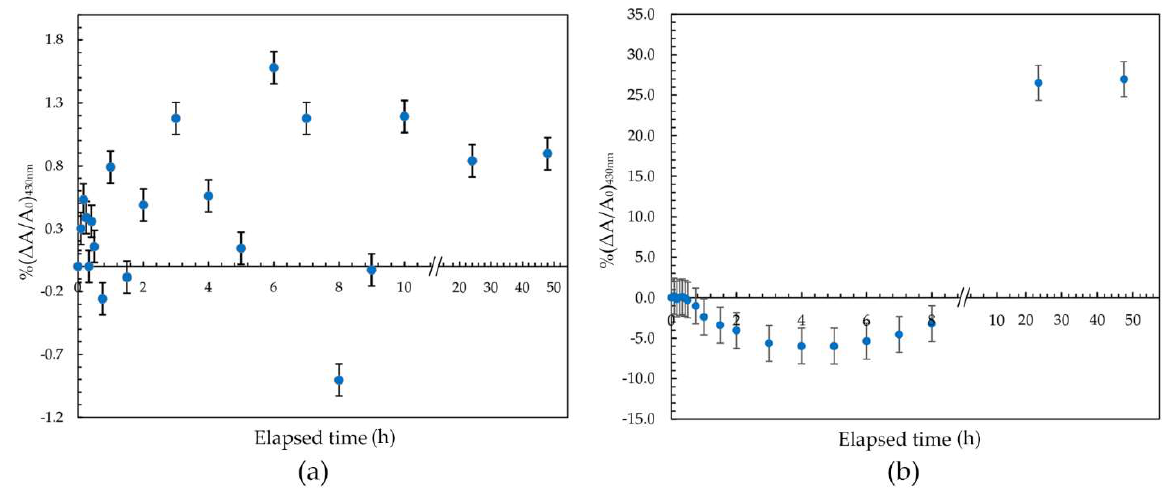
Figure 6. ( a ) Pre-irradiation (0 Gy) and ( b ) post-irradiation (100 Gy) stability of the PVA/AgNPs sensor during the first 48 h. sensor during the first 48